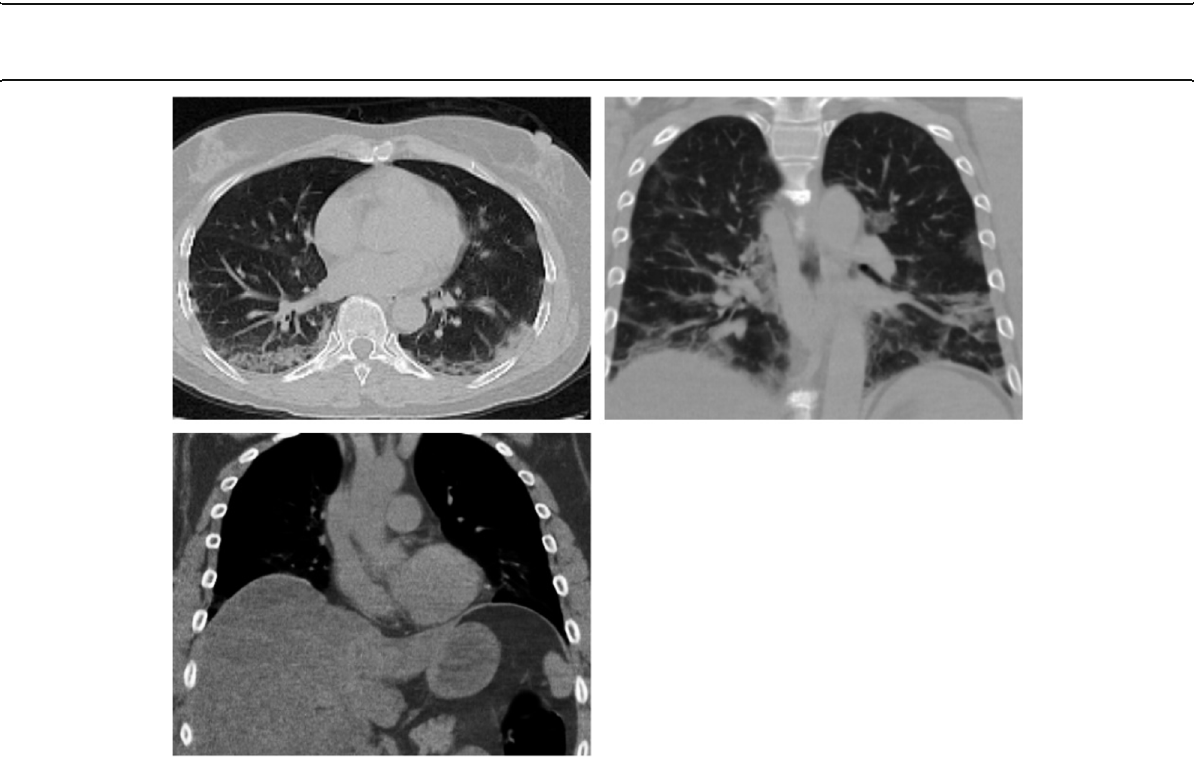
Fig. 4 Male patient, 64 years. CT chest shows bilateral lower lobar subpleural patchy ground-glass opacities with underlying interlobular septal thickening and atelectatic bands, reported as CORADs 5. Upper abdominal cuts show fatty